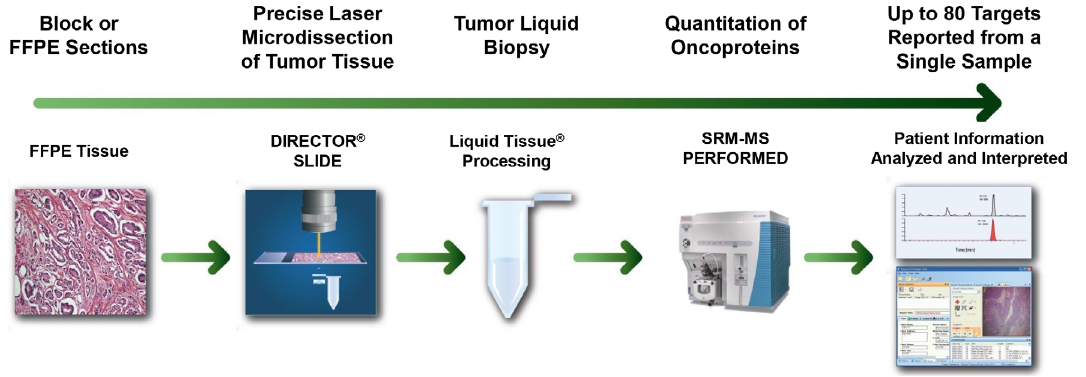
Figure 1. Liquid Tissue-Selected Reaction Monitoring (SRM) workflow for quantification of proteins from formalin-fixed paraffin- embedded (FFPE) tissue. Tissue sections are cut onto Director microdissection slides. After they are deparaffinized, areas of interest are identified by pathologists. Laser microdissection is used to procure areas of interest and the targeted cellular material is collected in a tube. The cellular material is processed using the Liquid Tissue protocol, which includes trypsinization, to produce a soluble peptide lysate. A known amount of heavy internal standard peptide is added to the lysate and the sample is analyzed using SRM to measure the absolute abundance of the endogenous peptide of interest.